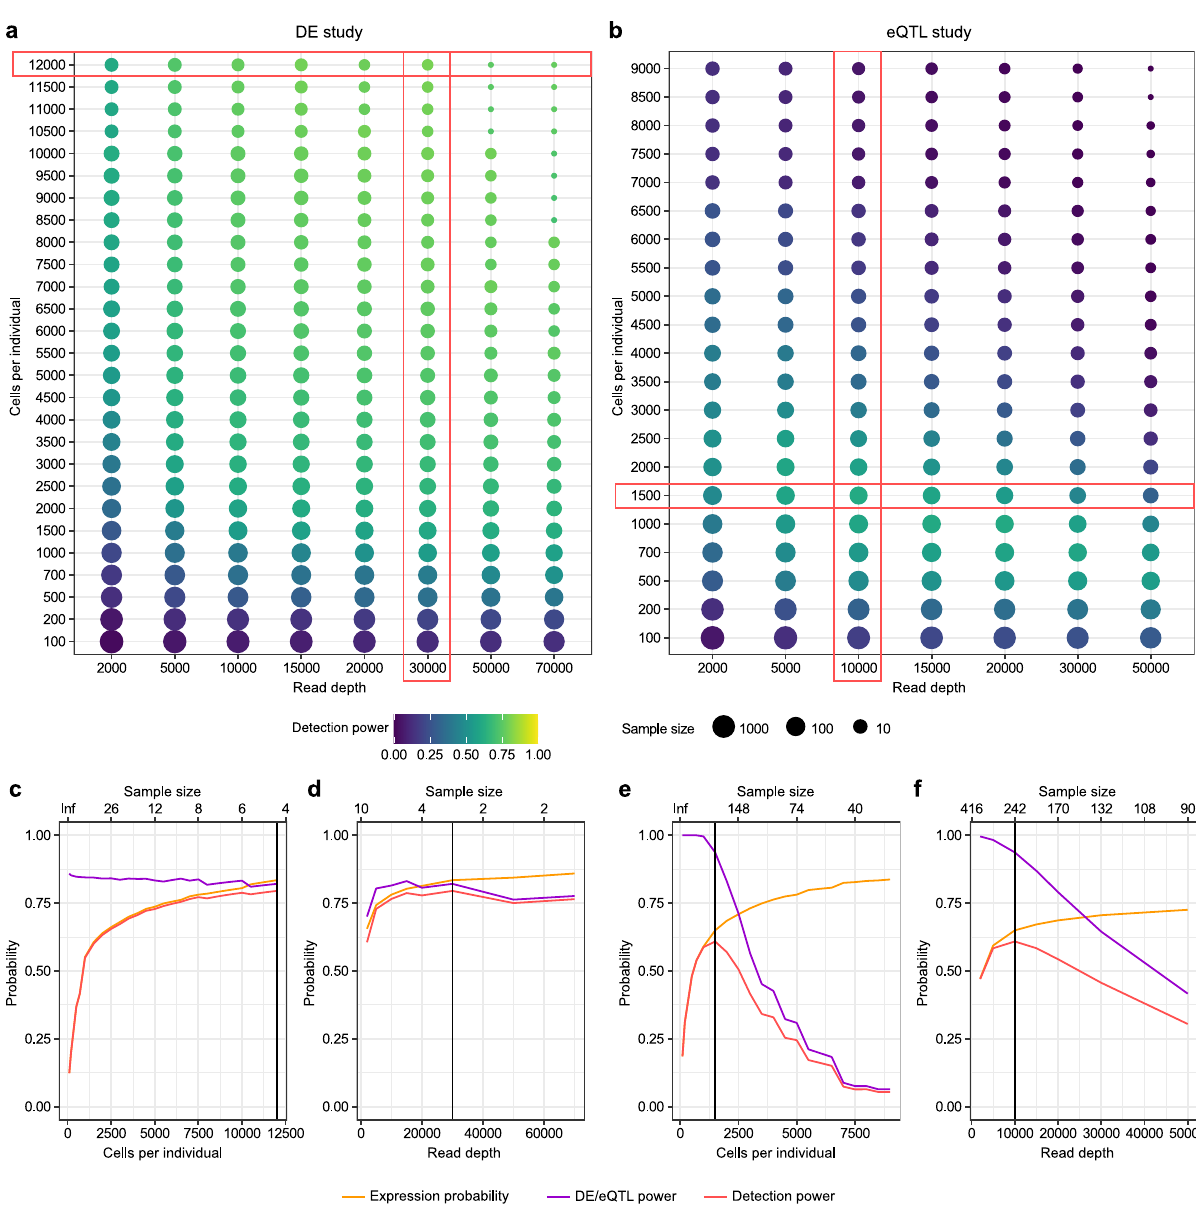
Fig. 4 Parameter optimization for constant budget. Maximizing detection power by selecting the best combination of cells per individual and read depth for a DE study with a budget of 10,000 € ( a ) and an eQTL study with a budget of 30,000 € ( b ). Sample size is uniquely de fi ned given the other two parameters due to the budget restriction and visualized using the point size. c – f Overall detection power dependent on cost determining factors. In fl uence of the cells per individual given the optimized read depth ( c , e ) and of the read depth given the optimized number of cells per individual ( d , f ). Corresponds to the DE study in ( a ), visualized in ( a ) by the red frame around the row with the optimal number of cells (corresponding to ( c )) and the red frame around the column with the optimal read depth (corresponding to ( d )). Same frames for ( e , f ) in the eQTL study ( b ). The optimal sample size values are shown in the upper x axes for ( c – f ). Vertical line in the subplots marks the optimal parameter combination. Effect sizes were chosen as in Fig. 3. Gene expression is de fi ned as detected in >50% (DE analysis) or >9.5% (eQTL analysis) of